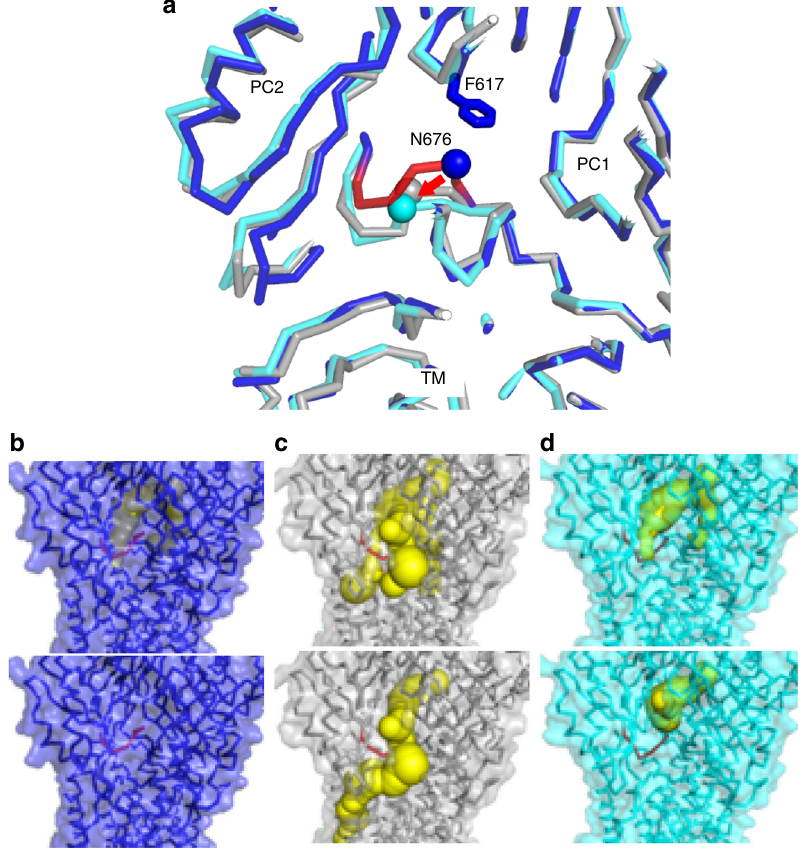
Fig. 5 Conformational change of MexB from the Resting state to the Binding state. a Superposition of the Resting state in the cryo-EM structure (blue), the Binding state in the crystal structure (PDB ID: 3w9i, gray), and the Binding state in the cryo-EM structure (cyan). Gate loops are colored in red. Red arrows indicate conformational changes of the gate loop. b – d Visualization of channels to the distal binding pocket, generated using caver v. 3.0.1 45 . Shown are the Resting state in the cryo-EM structure ( b ), the Binding state in the crystal structure ( c ), and the Binding state in the cryo-EM structure ( d ). Channels are shown as yellow spheres with diameters greater than 1.6 Å (top panels) and 2.0 Å (bottom panels). Atomic models are shown in ribbon diagram, and surface views are transparent with the same color as in a . Gate loops are colored in